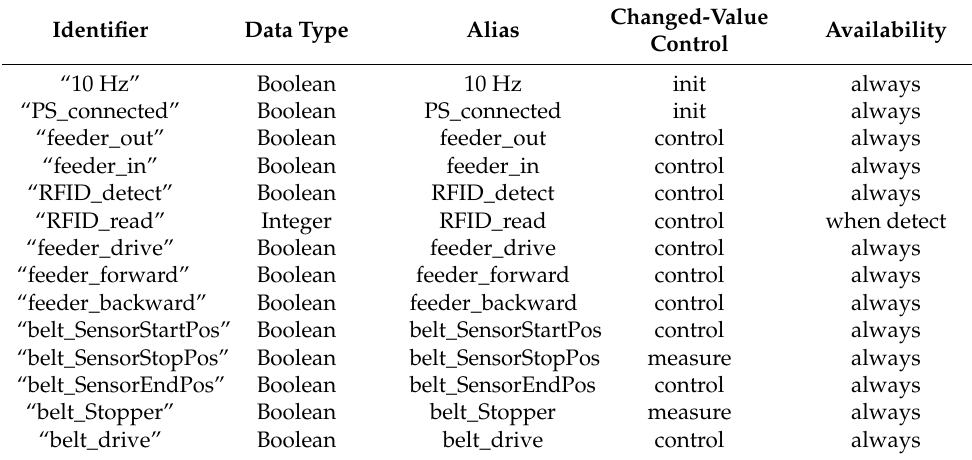
Table 1. OPC-UA data